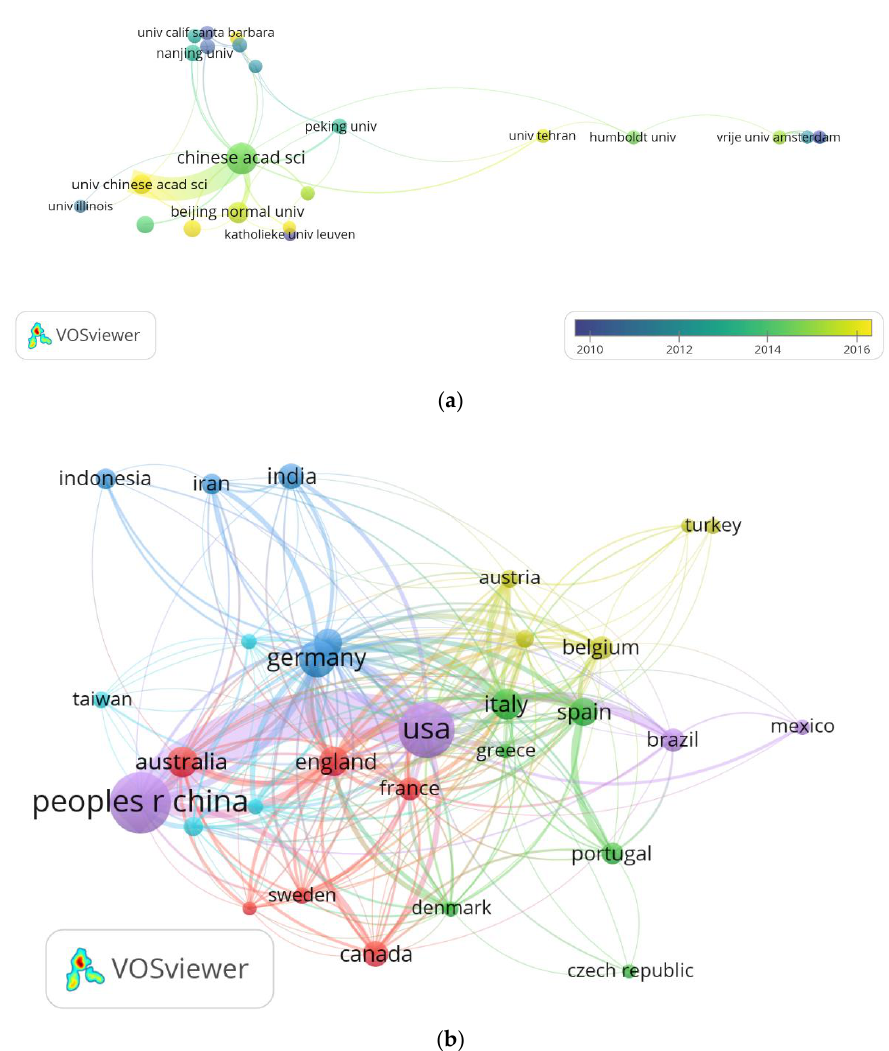
Figure 4. Cooperation network of ( a ): organizations with 10 documents threshold; ( b ): countries with 15 documents threshold.